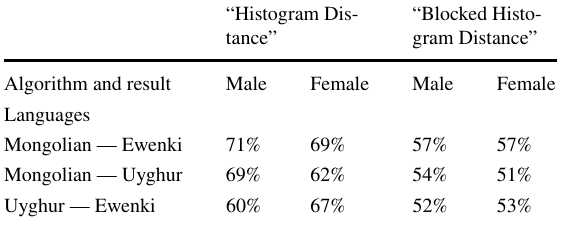
Table 3 Comparison of acoustic distribution patterns of Vowels in three languages (parameter)